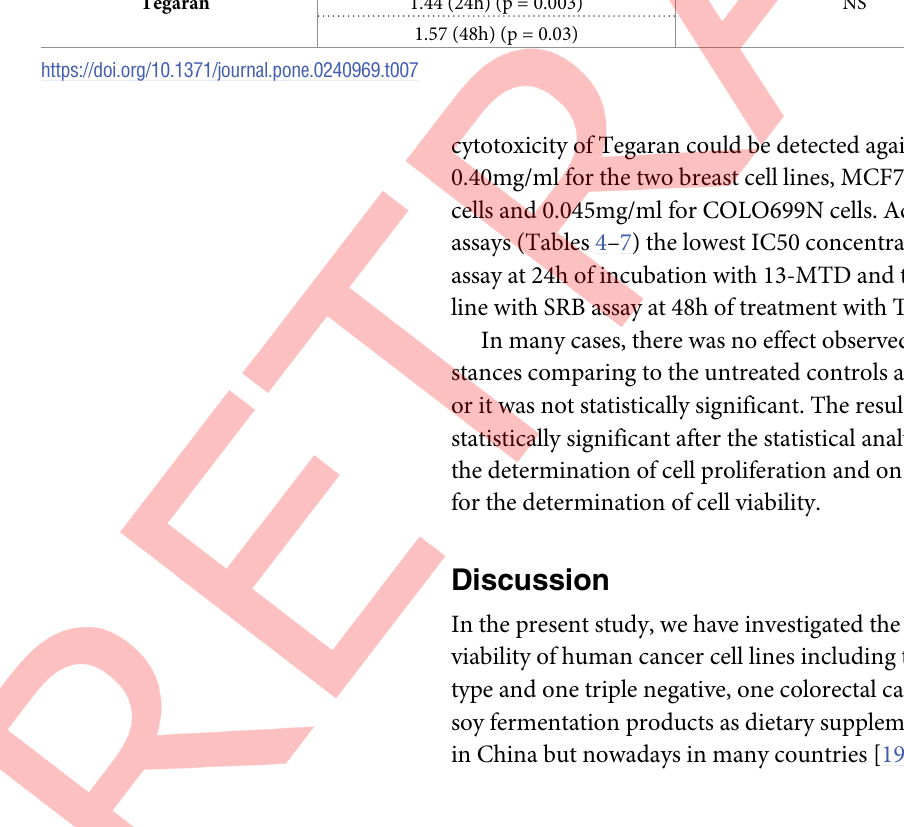
Table 7. COLO699N cell line IC50 concentrations for 13-MTD and Tegaran according to CVE, SRB and MTT assay (NS- No significant). COLO699N 13-MTD